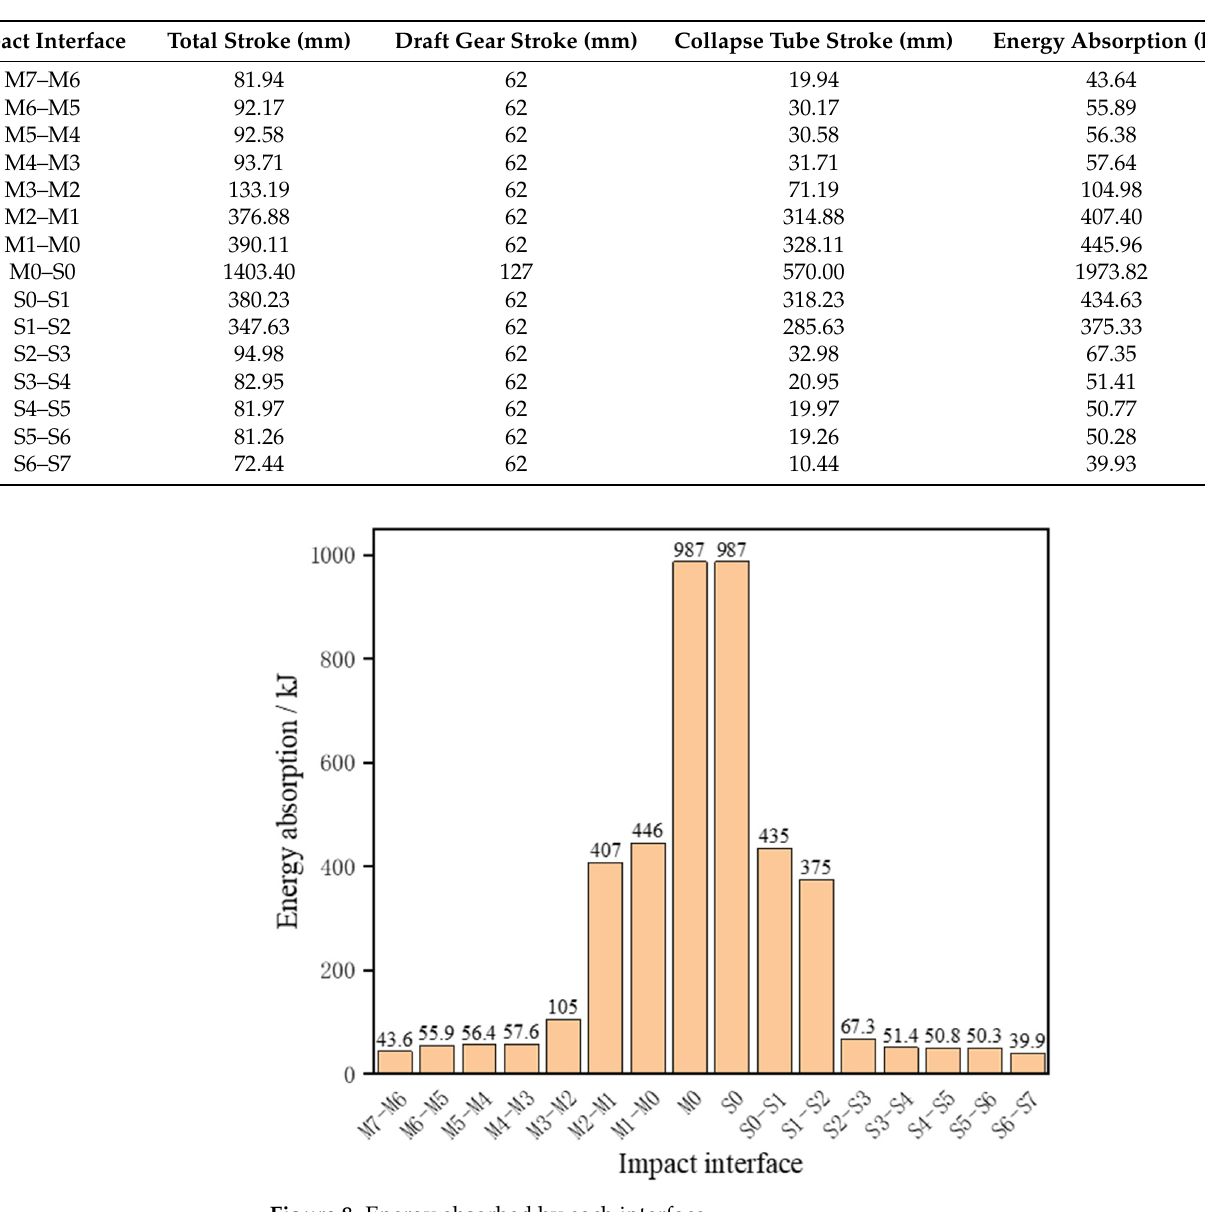
Figure 8. Energy absorbed by each interface. Table 2. Simulation results.